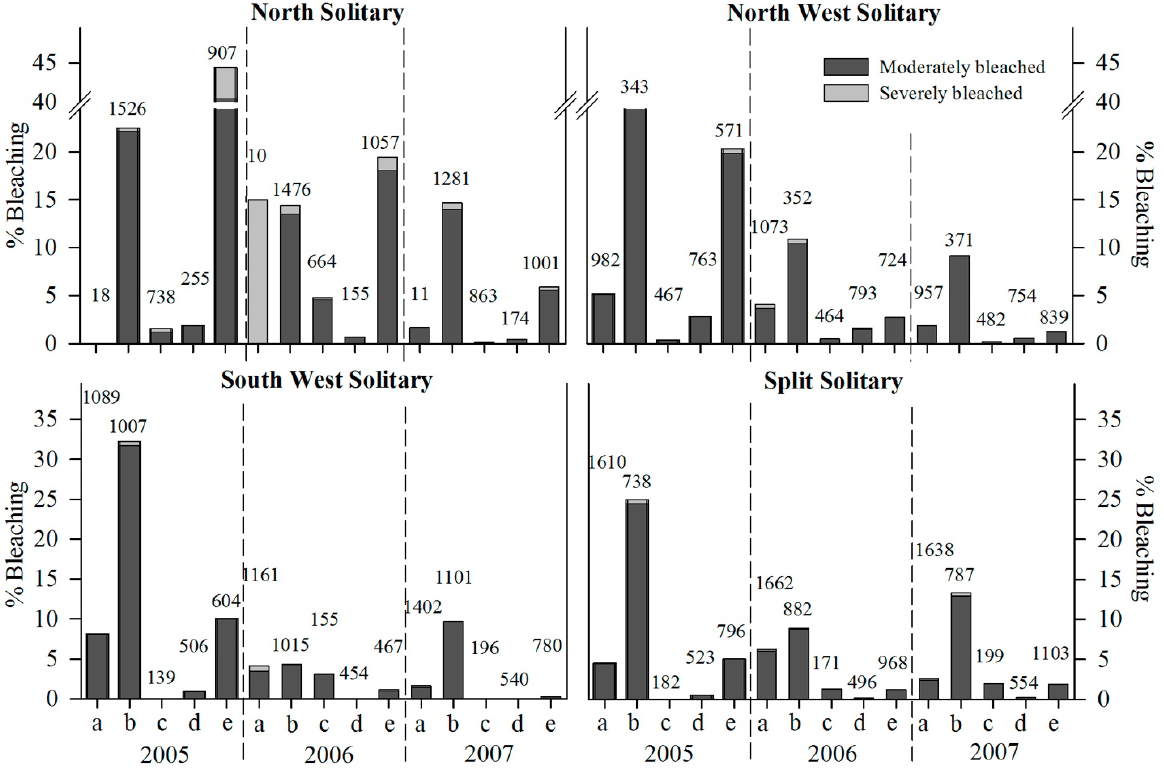
Figure 3. Average proportion of bleaching response (moderate-dark grey and severe-light grey) recorded for different coral families during coral health and bleaching surveys at four island locations within the SIMP. ( a ) Dendrophylliidae; ( b ) Pocilloporidae; ( c ) Acroporidae; ( d ) Faviidae; and ( e ) Poritidae. Numbers above bars indicate the total number of colonies counted within each family at each